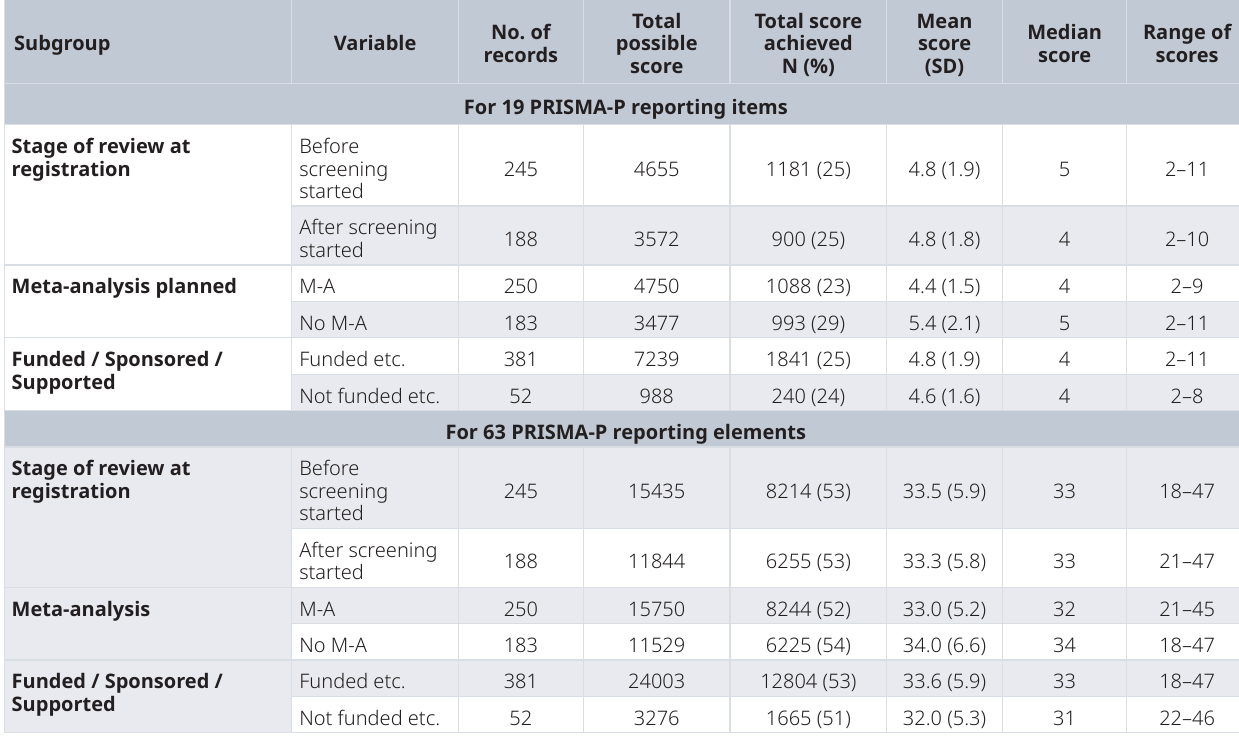
Table 3. Subgroup